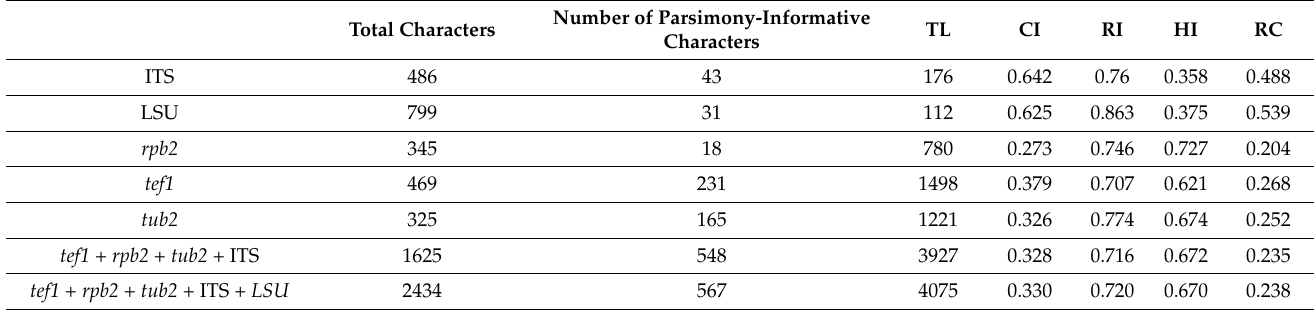
Table 3. Parameters for MP